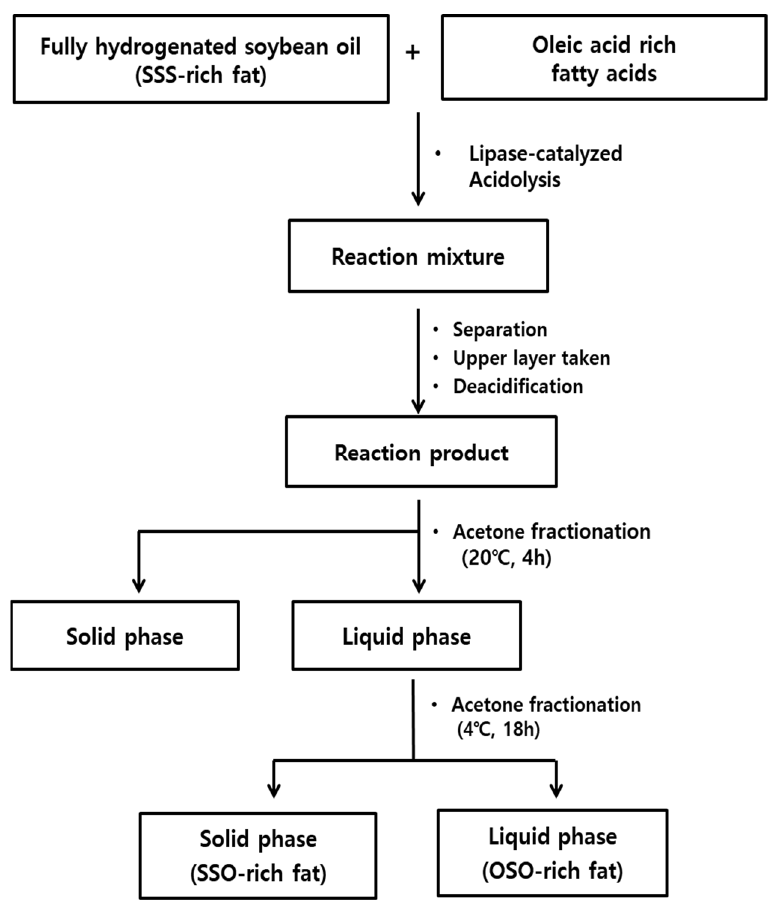
Figure 7. Production scheme of SSO-rich and OSO-rich fats.